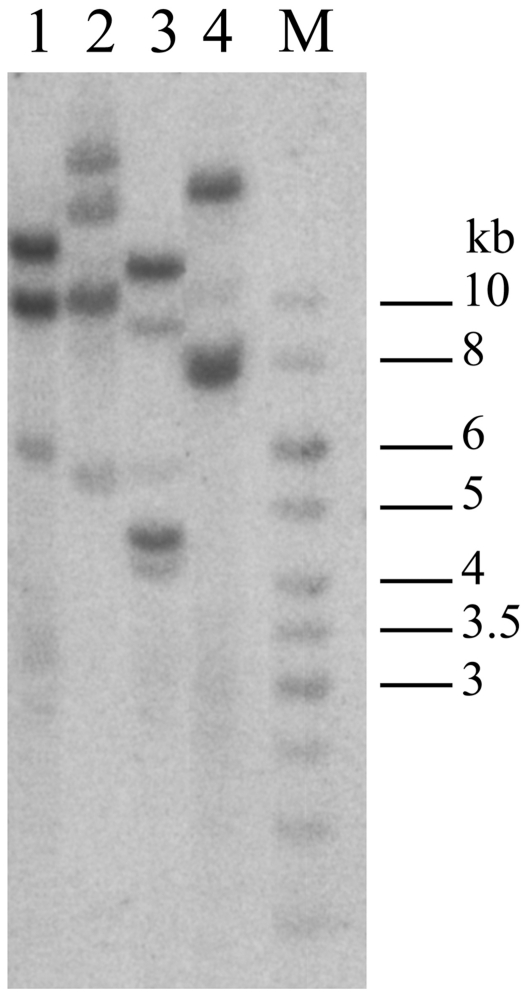
Southern blot of camel genomic DNA with PCR-probe to hspA1A/B genes.1 – BamHI, 2 – XbaI, 3 – XbaI/BamHI, 4 – EcoRI. M – fragment length markers.